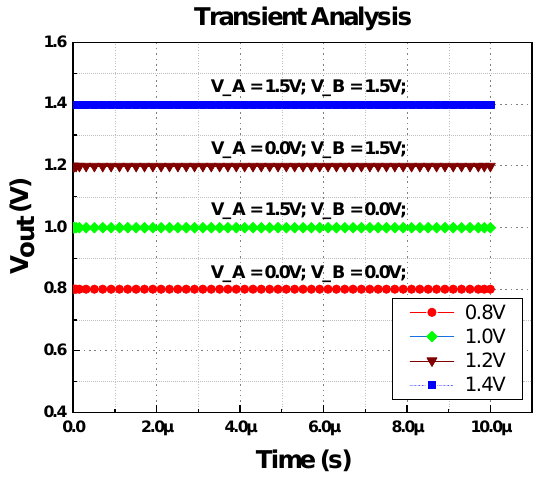
Line regulation of LDO computes from the measured result from Figure 12 when the supply voltage is 1.5 V. For output voltage of 0.8 V, the line regulation is 1.85 mV/V, while for 1.0 V regulated voltage, the line regulation is 2.7 mV/V. Besides this, the line regulation values for output voltages of 1.2 V and 1.4 V are 2.19 mV/V and 3.53 mV/V, respectively. The transient analysis of the measured waveform is shown in Figure 13. All four regulated output voltages look stable.